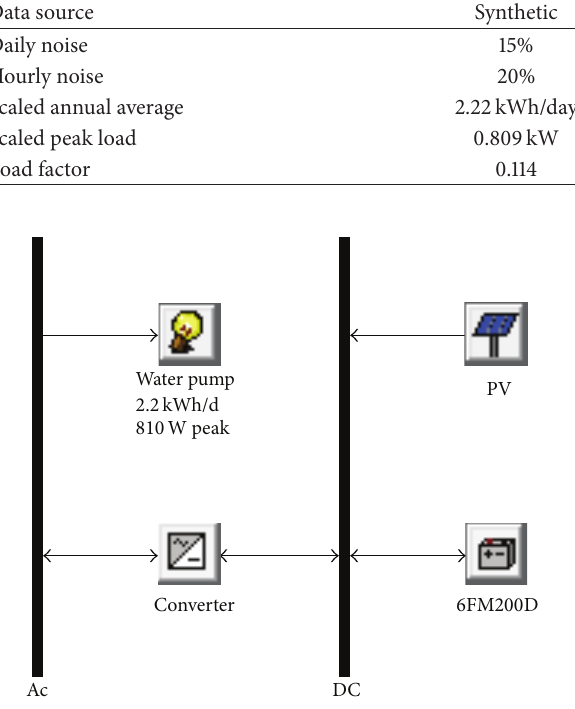
Figure 5: HOMER schematic diagram for the solar PV water pumping